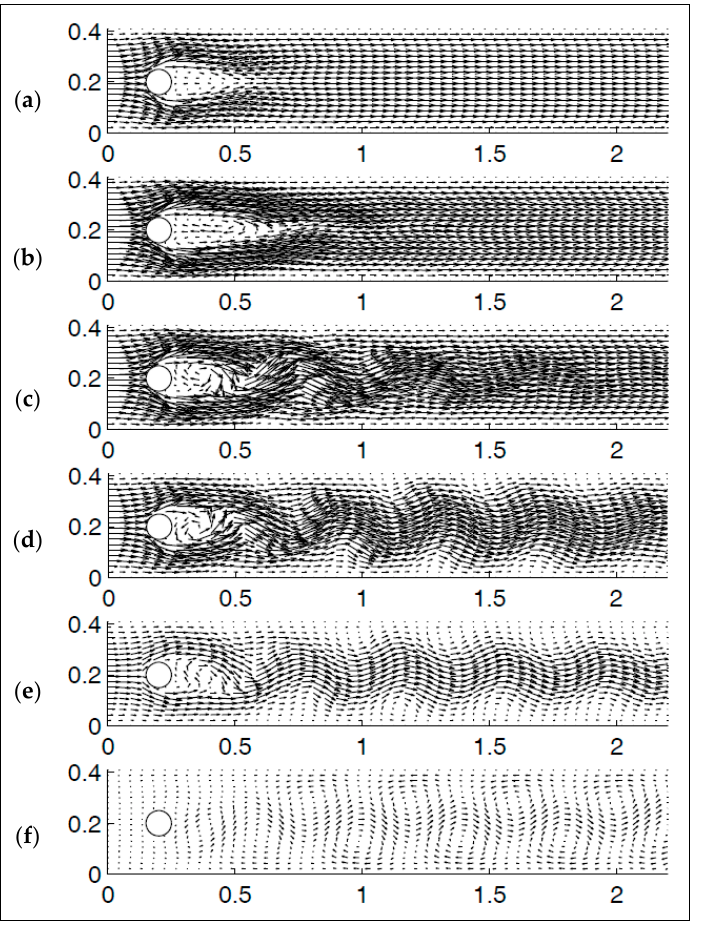
Figure 10. Velocity snapshots presented from ( a – f ) at t = 2, 4, 5, 6, 7, and 8 for level-3 mesh with (cid:52) t = 0.00125, viscosity ν = 10 − 3 , χ = 0.01 and N = 0.